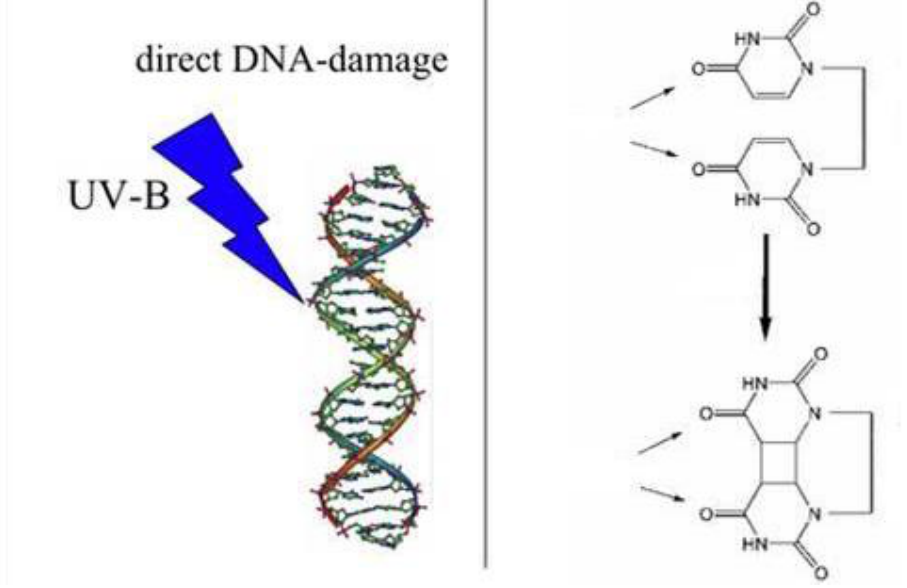
Figure 2. UVB DNA damage. UVB radiation may lead to direct DNA damage, inducing the development of thymine dimers, whereby adjacent thymine bases bond with each other instead of across the DNA backbone ladder. This thymine dimer makes a bulge, and the distorted DNA molecule does not function properly